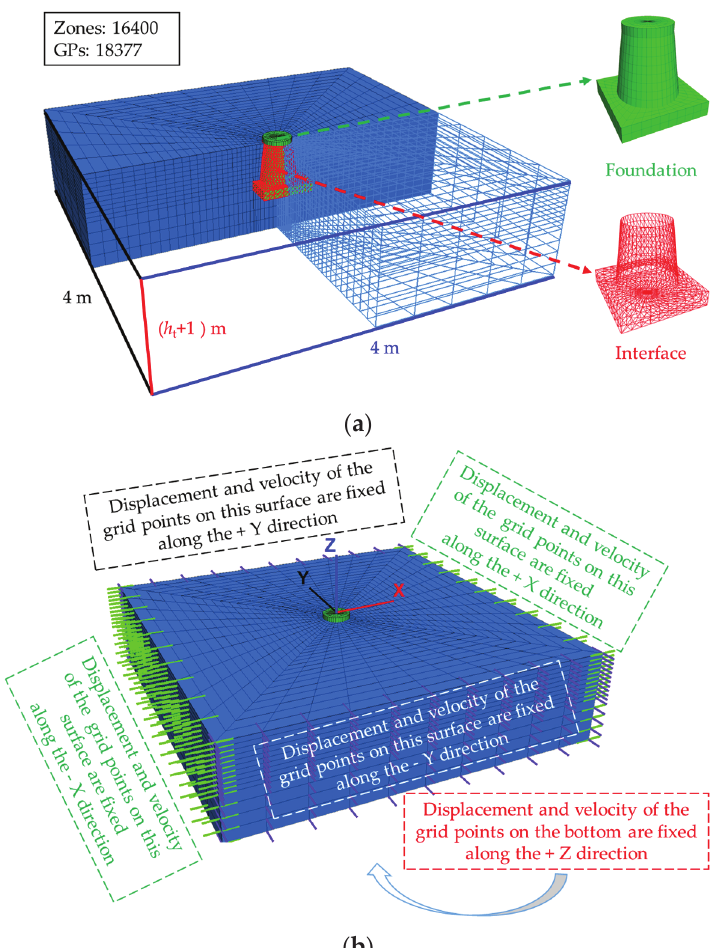
Figure 11. The diagram of mesh generation: ( a ) foundation, interface, and sizes and ( b ) boundary conditions.